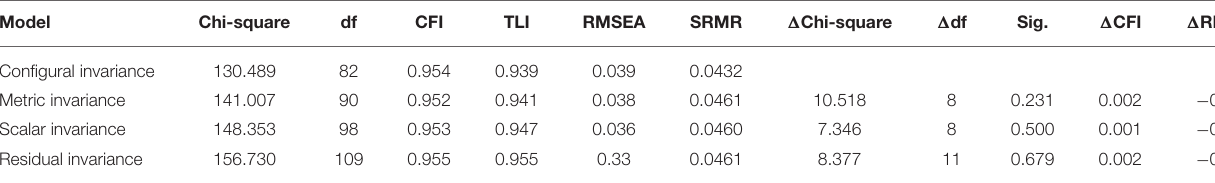
TABLE 5 | Persian version of Ageism survey model comparison for gender invariance. Model Chi-square df CFI TLI RMSEA